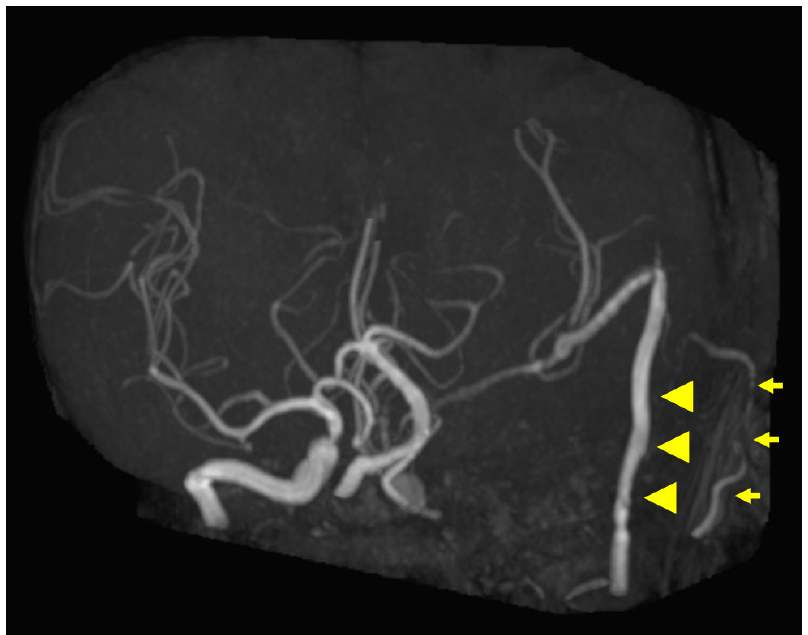
Figure 5. Postoperative magnetic resonance angiography (MRA) findings. MRA shows high-flow radial artery bypass between the M2 segment of the left middle cerebral artery (MCA) and the left cervical external carotid artery, with an additional superficial temporal artery (STA)–MCA bypass. Peripheral cerebral blood flow is maintained by the bypasses. The left internal carotid artery is trapped, and no blood flow is observed. Arrowheads indicate the high-flow bypass, and arrows indicate the STA–MCA bypass.